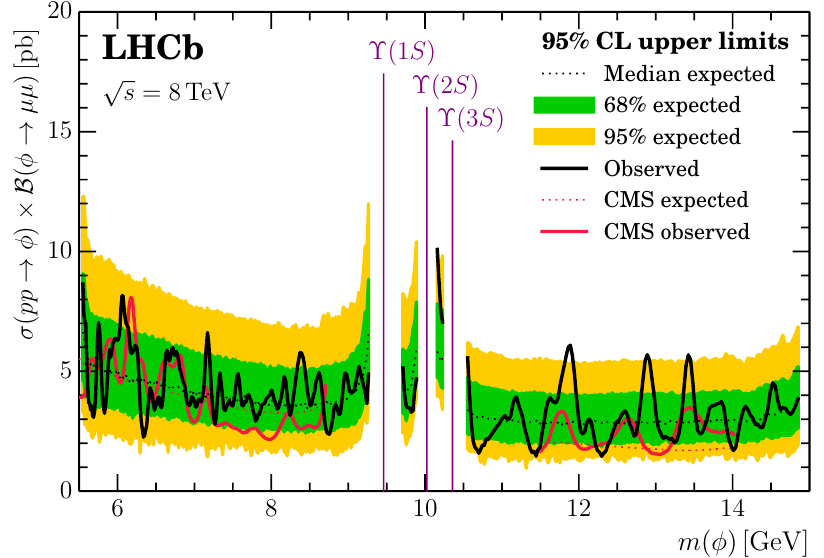
Figure 4 . Upper limits on the direct production of a spin-0 boson decaying to (cid:22) + (cid:22) (cid:0) in 8 TeV pp